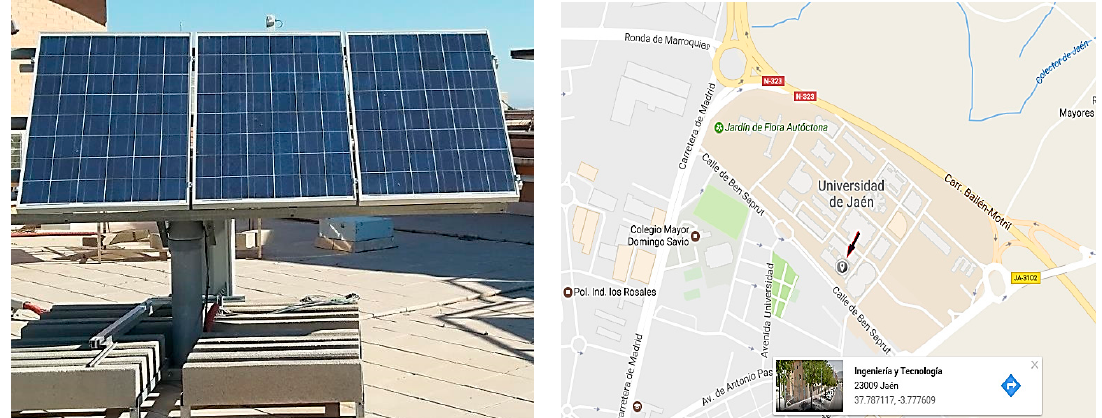
Figure 1. Photovoltaic self-consumption system at 555 Wp. Location of the photovoltaic system.